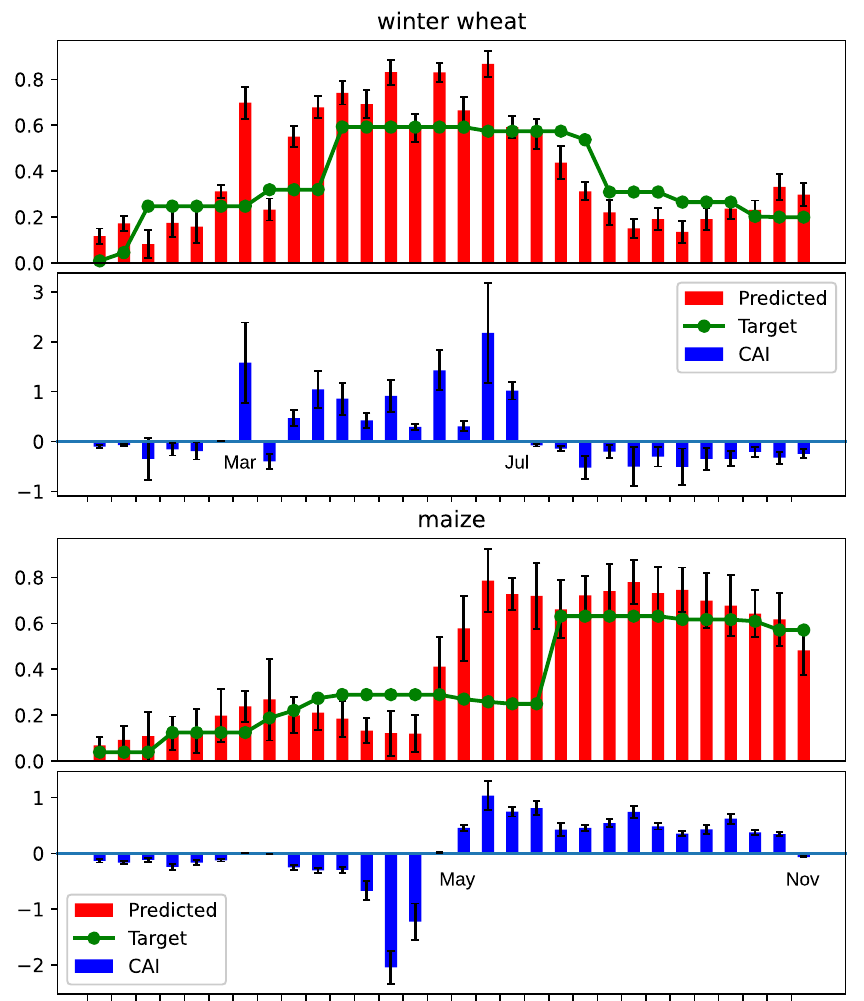
Figure 3. Two real examples showing the target NDVI index (green line) for two different test examples extracted from the Munich test set. The outputs predicted by the network for each pixel of the input sample are represented by mean and variance values (red bars). In blue, the value of the Class Activation Interval for the two classes winter wheat ( Top panel ) and maize ( Bottom panel ).